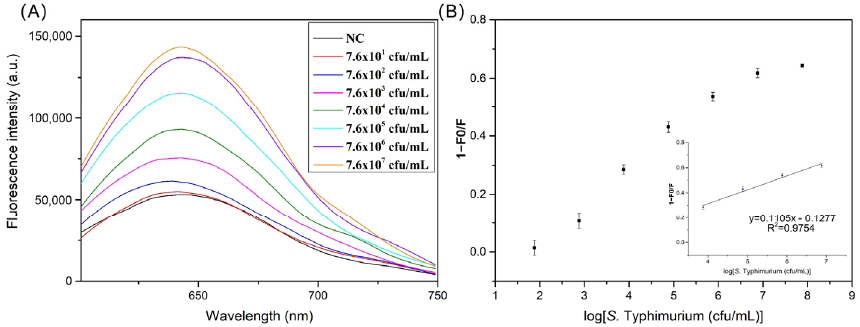
Figure 7. Sensitivity detection of S. Typhimurium in milk samples by an established aptasensor. ( A ) The fluorescence emission spectra response with the concentrations of S. Typhimurium in artifi- cially contaminated milk ranged from 7.6 × 10 1 to 7.6 × 10 7 cfu/mL. NC: negative control. ( B ) The relationship between the fluorescence ratio (1 − F0/F) and the logarithm of the concentration of S. Typhimurium. Inset: the linear relationship between the (1 − F0/F) and the logarithm of the concen- tration of S. Typhimurium. The error bars show the standard deviations of 3 repetitive experiments.